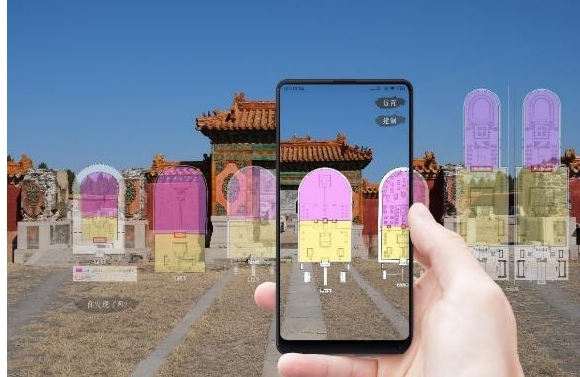
Figure 44. The structure of lower cornice is completed